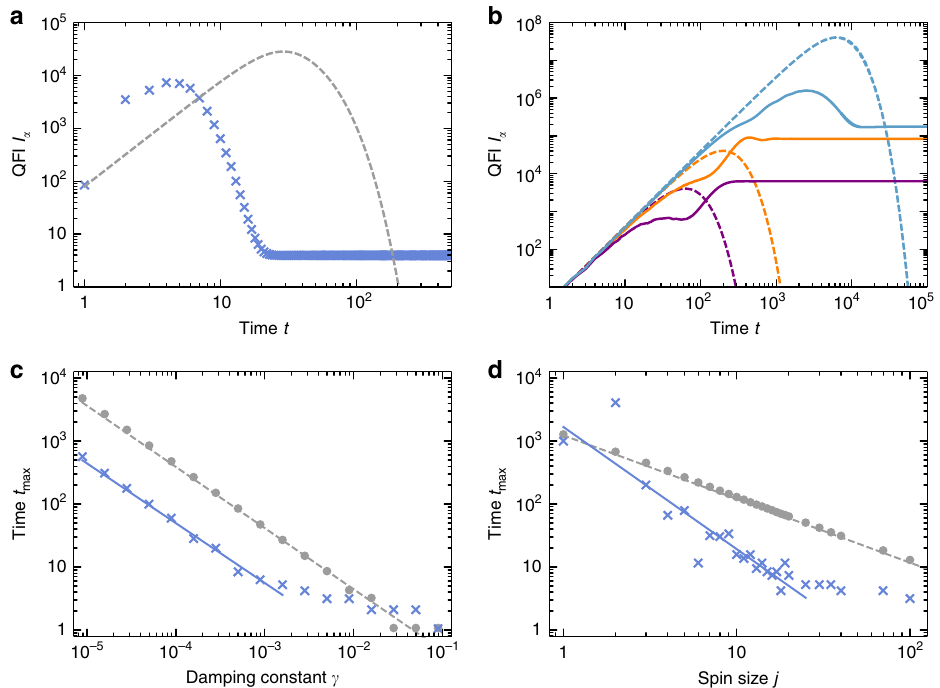
Fig. 5 Time evolution of the quantum Fisher information (QFI) for the dissipative kicked top. In all subplots, we look at an initial coherent state at ( θ , ϕ ) = ( π /2, π /2). a Exemplary behavior as function of time for a dissipative top (DT, dashed gray line) and a chaotic (kicking strength k = 30) dissipative kicked top (DKT, blue crosses) for spin size j = 40, damping constant γ = 0.5 × 10 − 3 . b High plateau values of the QFI are achieved for j = 2 and k = 30 for various values of the damping constant ( γ = 0.5 × 10 − 2 for the purple line, γ = 1.58 × 10 − 3 for the orange line, and γ = 0.5 × 10 − 4 for the blue line), while dashed lines represent corresponding QFI with k = 0. c , d Time t max at which the QFI of the DT (gray dots) and DKT (blue crosses) reaches its maximum as function of γ and j , respectively. The fi ts for the DT (gray line) exhibit a slope of − 0.97 and − 1.01, and the fi ts for the DKT (blue, dashed) a slope of − 0.95 and − 1.94 for scaling with γ and j , respectively. Parameters j = 15 in c and γ = 0.5 × 10 − 3 in d . The plotted range of the fi ts corresponds to the fi tted